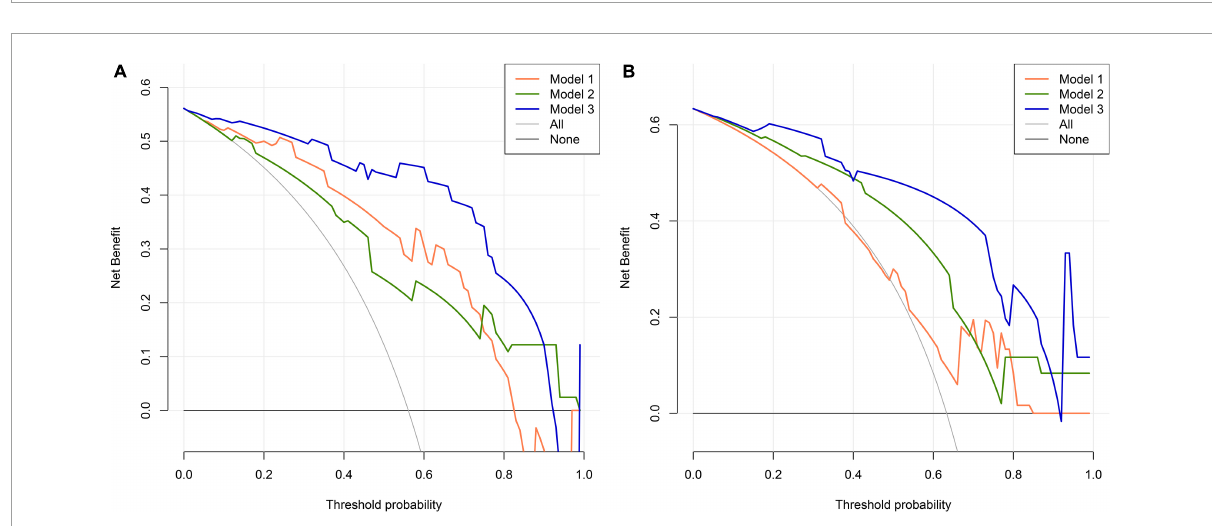
FIGURE5 Decision curve analysis (DCA) for PSCI nomogram. (A) Development cohort; (B) validation cohort. The abscissa represents the threshold probability and the y-axis represents the net